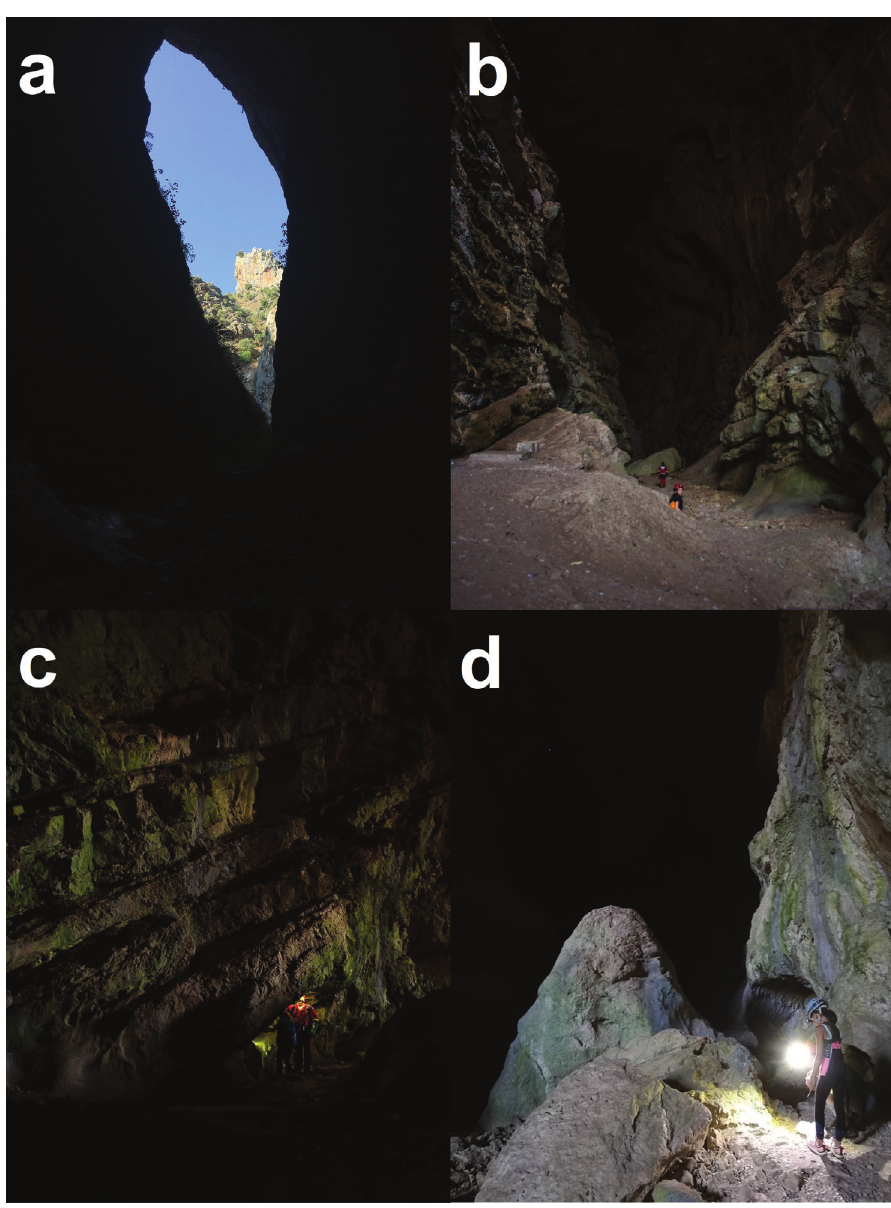
Figure 2. Hundidero Gato cave a exterior view from Hundidero b Hundidero entrance c, d dark zone, making direct captures (Photo by Miguel de